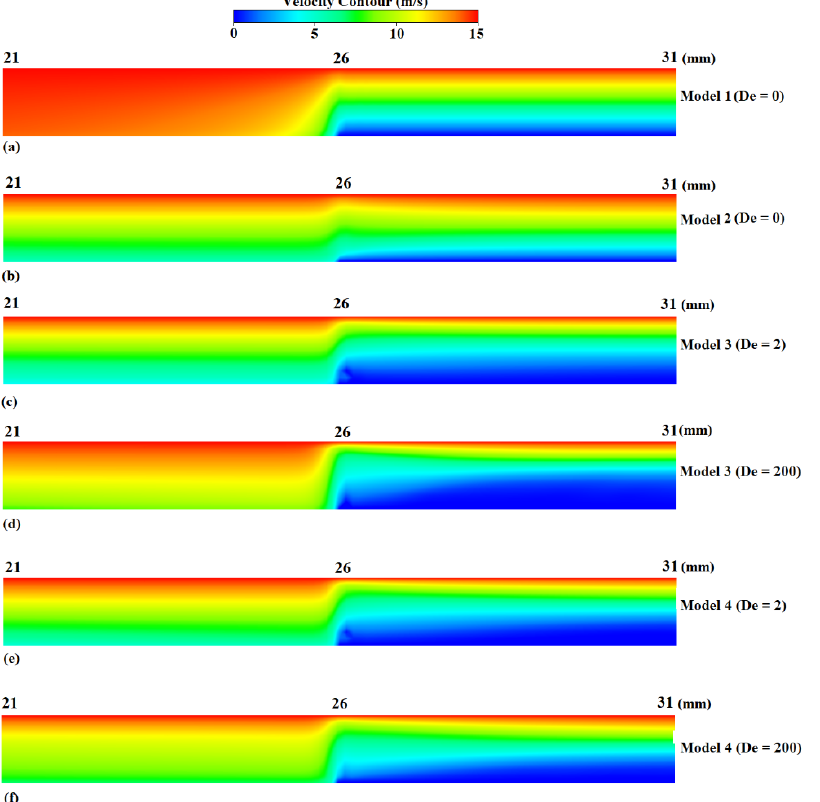
Figure 11. Velocity magnitude contours at regions adjacent to the blade and on blade position.